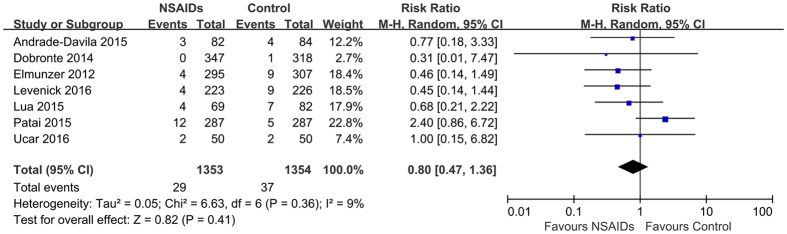
Forest plot showing no statistic differences in adverse events attributable to NSAIDs therapy.CI, confidence interval; M-H, Mantel-Haenszel; NSAIDs, nonsteroidal anti-inflammatory drugs.